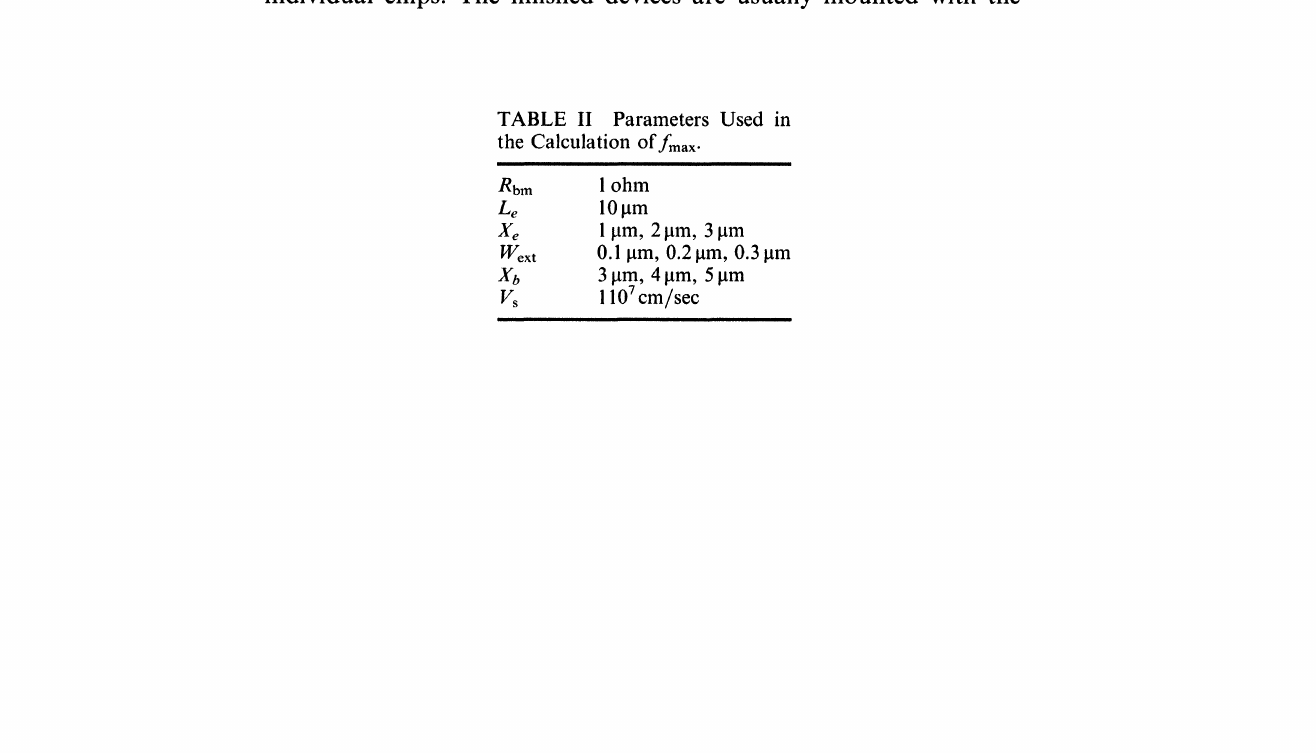
TABLE II Parameters Used in the Calculation